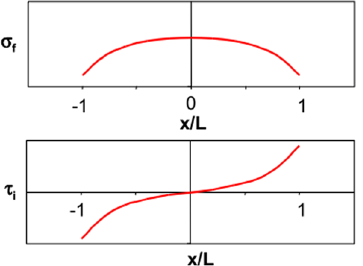
Fig. 4 Cox model; Stress profiles in the fiber ( σ f ) and at the interface (